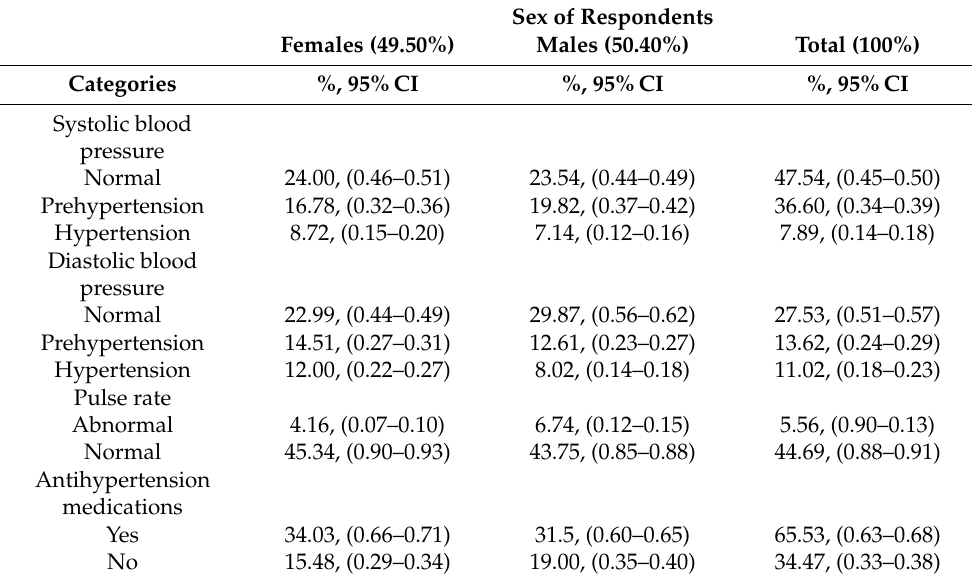
Table 2. Prevalence of Blood Pressure, Pulse Rate and Intake of Antihypertension Medications among Males and Females in Bangladesh.